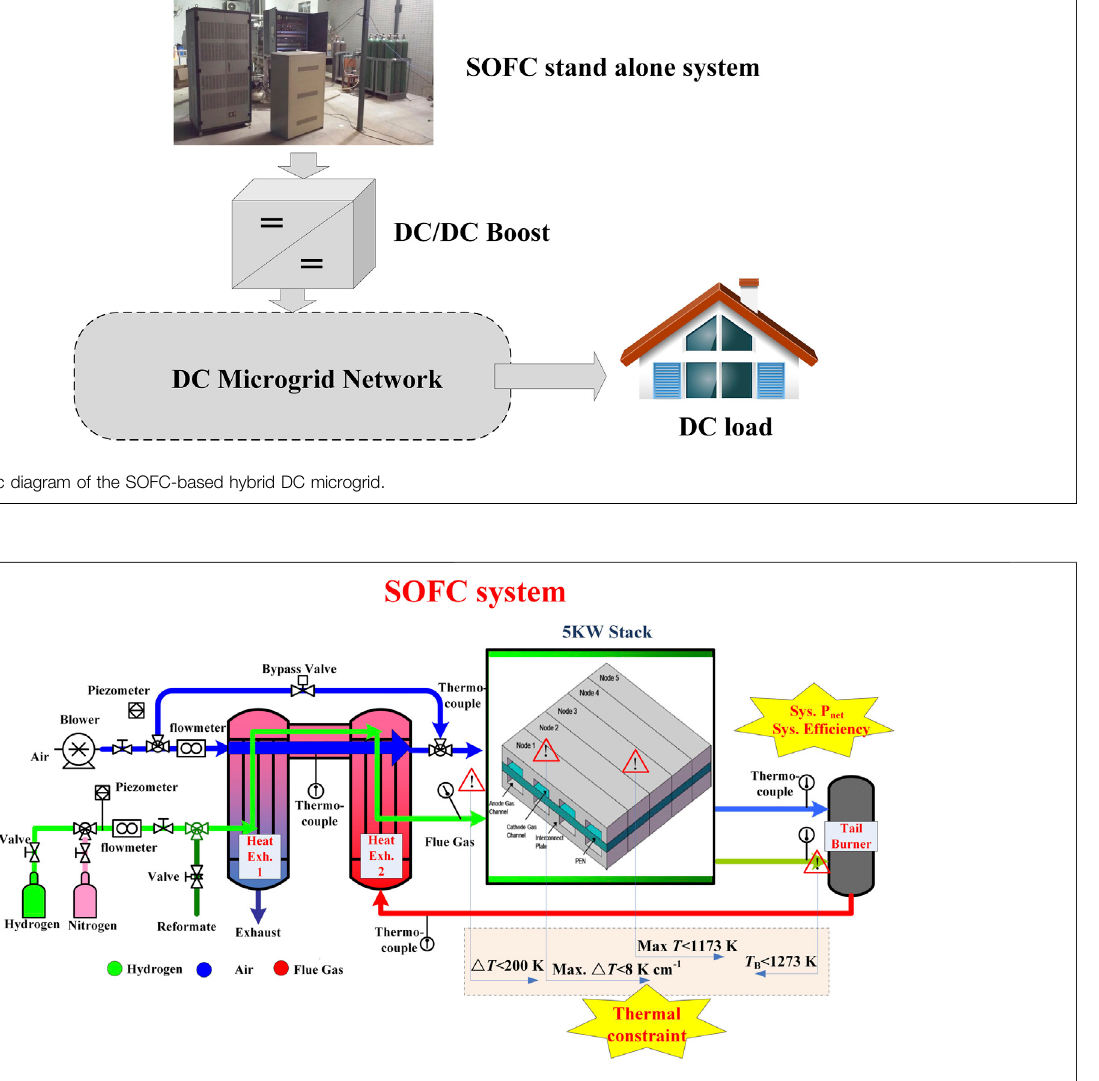
FIGURE 2 | Overall SOFC stand-alone system